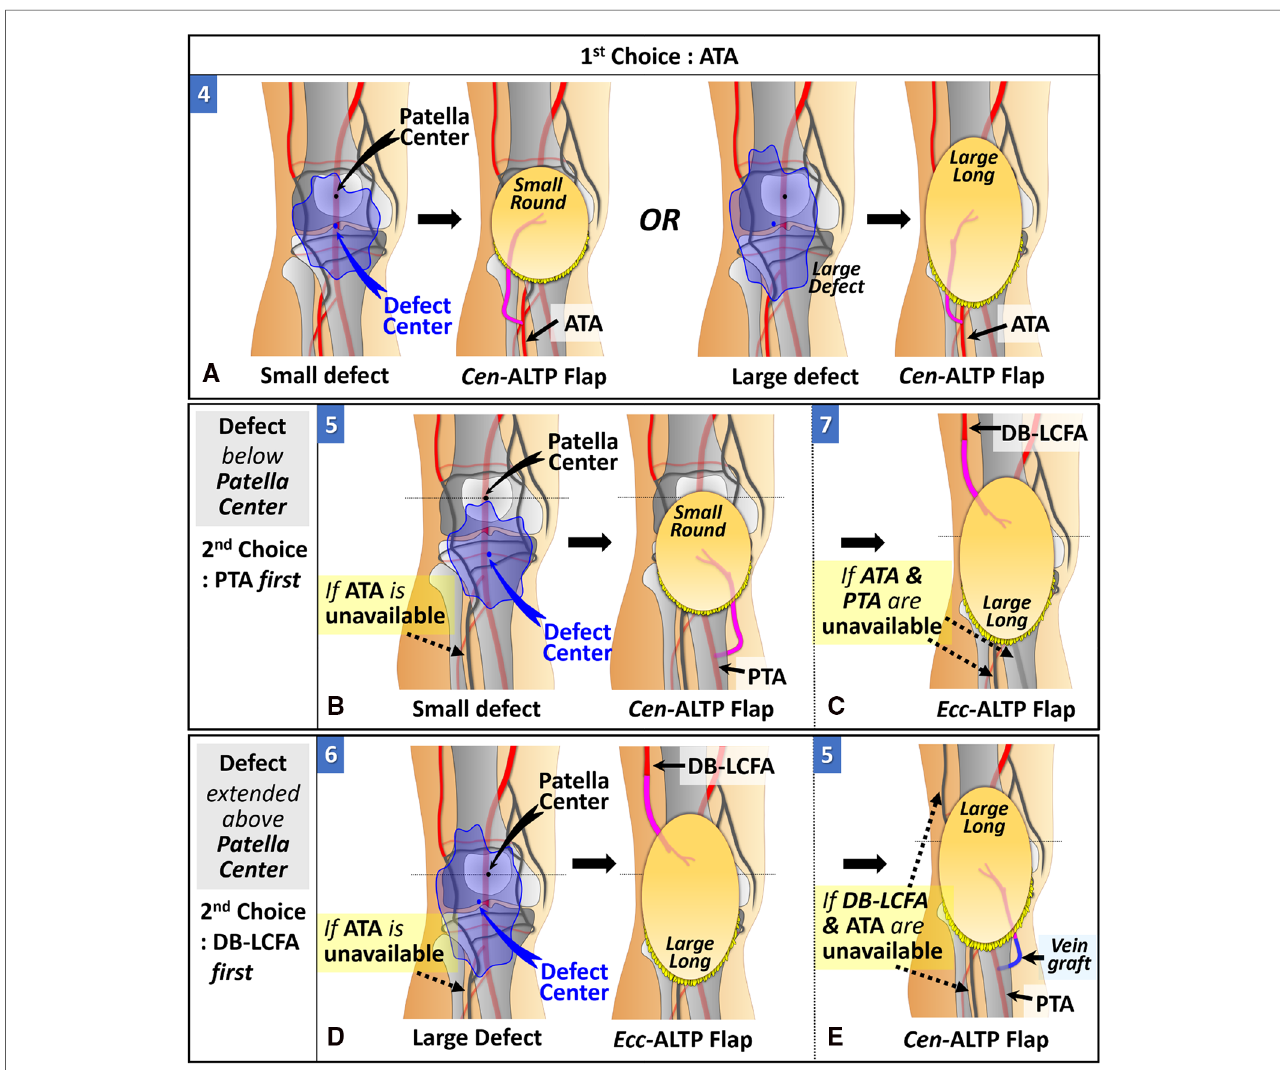
FIGURE 6 Algorithmic options for soft tissue defects below the patella in which the defect center is located below the patella center. (The number in each fi gure piece indicates the corresponding option number in the algorithm) ( A ) ATA is the fi rst choice as a recipient vessel because of its proximity to the defect and easy accessibility. Depending on the defect size, Cen-ALTP fl ap with a small round or large long skin paddle can be used for free tissue transfer. ( B ) if the ATA is unavailable to use and the whole defect is located below the patella center, PTA (1st choice) or DB-LCFA (2nd choice) could be used as a recipient vessel. Firstly, if only ATA is unavailable as a recipient vessel, Cen-ALTP fl ap with small round skin paddle, which is anastomosed to PTA, is used for free tissue transfer. ( C ) Secondly, if both ATA and PTA are unavailable as recipient vessels, Ecc-ALTP fl ap with large long skin paddle, which is anastomosed to DB-LCFA is used. ( D